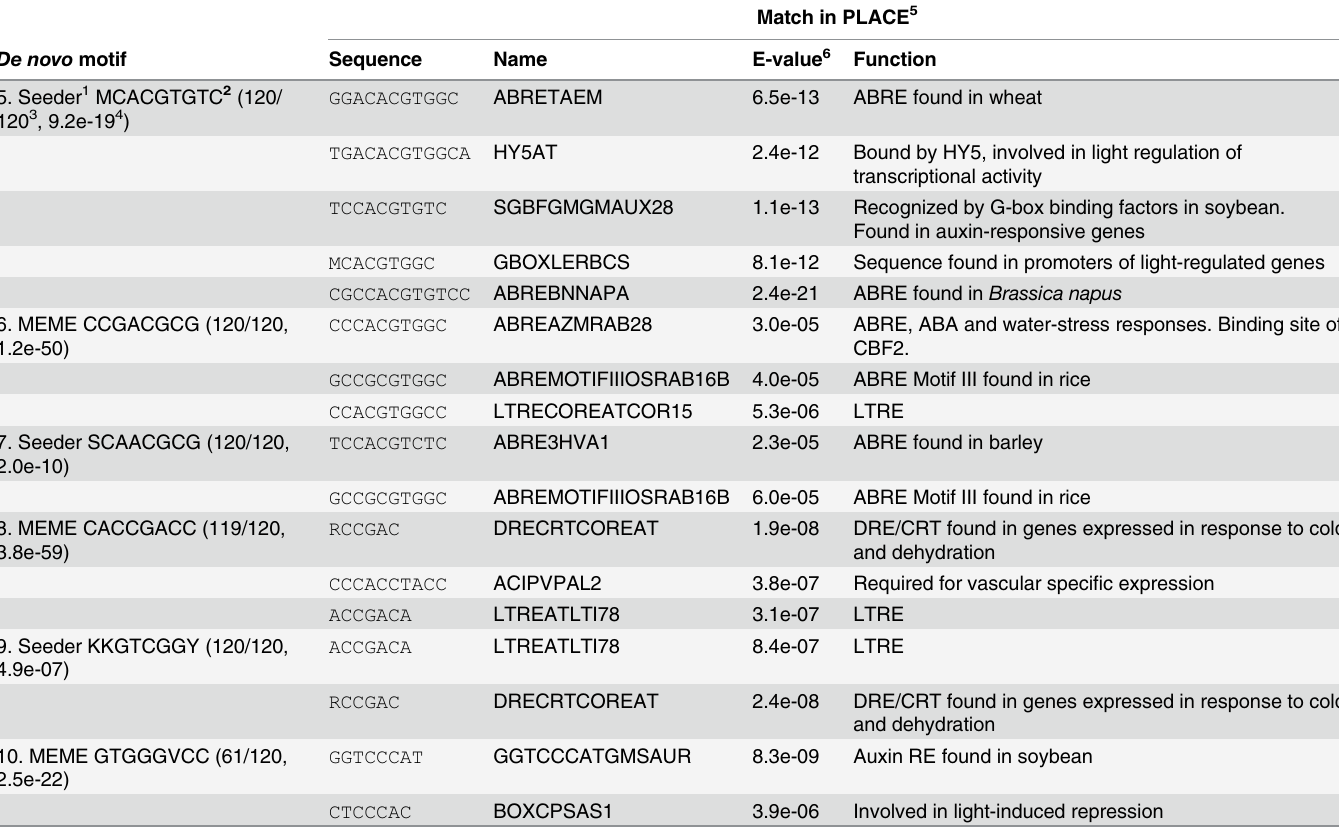
Match in PLACE 5